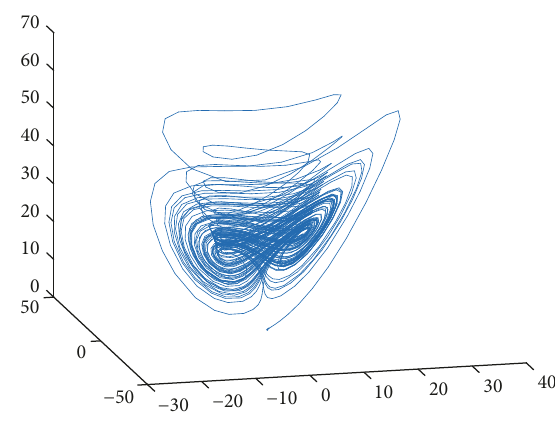
Figure 1: Chen attractor with a = 35, b = 3, and c =